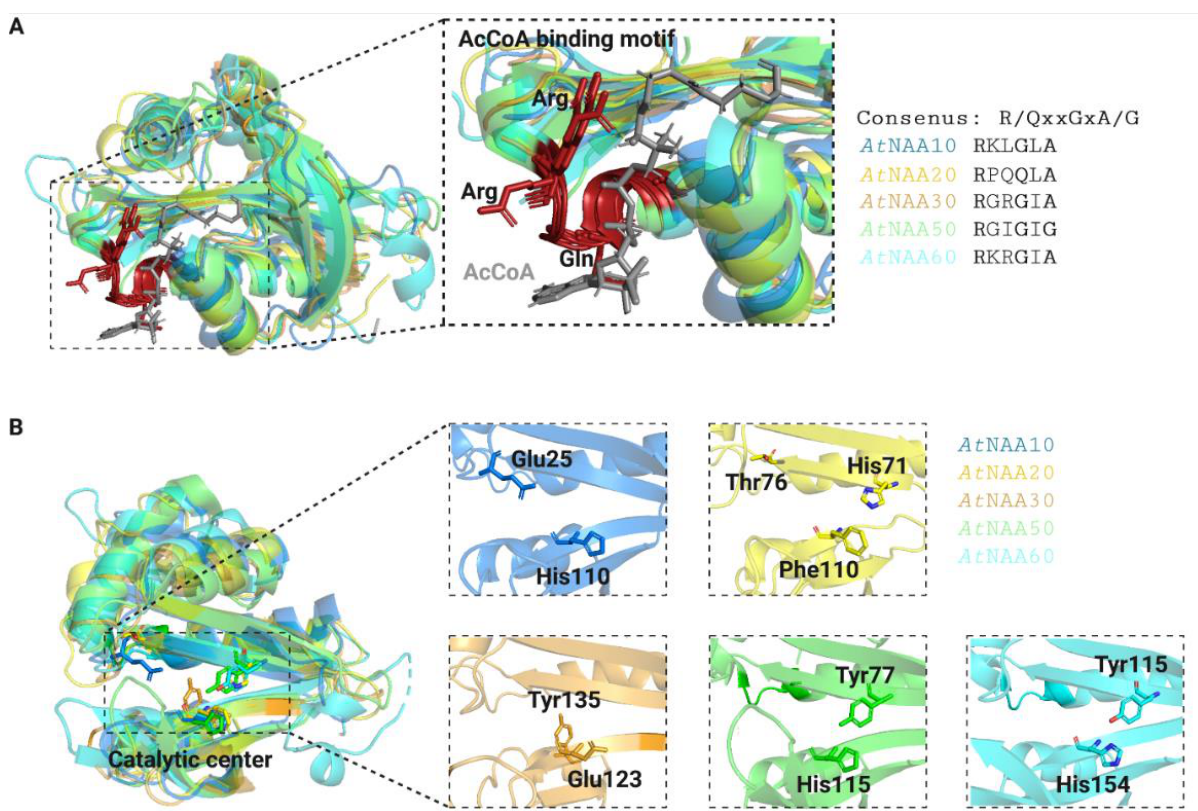
Figure 4. Three-dimensional models of Arabidopsis thaliana Nats. The AcCoA-binding motives ( A ) of Arabidopsis Nats are strongly conserved (shown in red with conserved residues highlighted in ribbon mode). AcetylCoA is represented in grey. The Nat catalytic sites ( B ) have distinct surface characterizations in shape, size, and electrostatic properties, which is consistent with their ability to acetylate distinct substrate pools. Catalytically important residues were either reported in [1,2] for At NatE and At NatF or estimated based on their human and yeast counterparts for At NatA–C [3] and are represented in stick mode. The crystal structures of At NAA50 (6YZZ, green) and At NAA60 (6TGX, cyan) were downloaded from the Protein Data Bank (https://www.rcsb.org, accessed on the 9 November 2022), whereas the three-dimensional structures of the other Nats were generated with SwissModel (https://swissmodel.expasy.org, accessed on the 9 November 2022) based on their human or yeast counterparts using the templates 6c9m.2.B ( At NAA10, blue), 7stx.1.A ( At NAA20, yellow) and 7l1k.1.A ( At NAA30, orange).